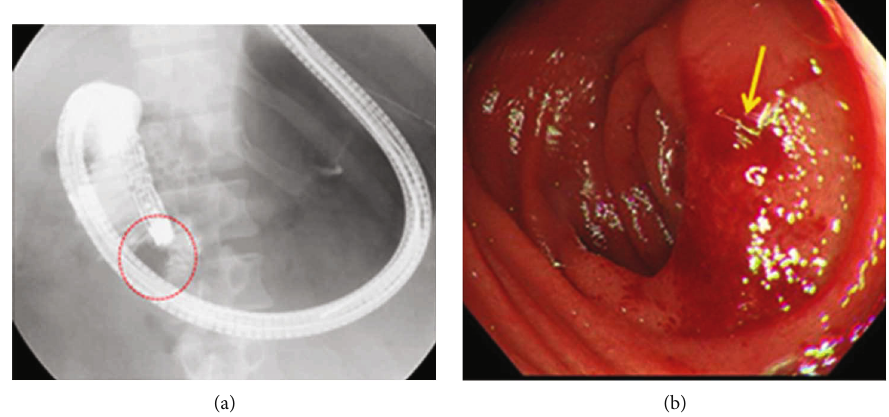
Figure 5: EGD fi ndings in Case 1 on POD15. (a) EGD could not pass through the duodenal descending portion (dotted area). (b) Extrinsic compression with redness (arrow) was seen at the duodenal descending